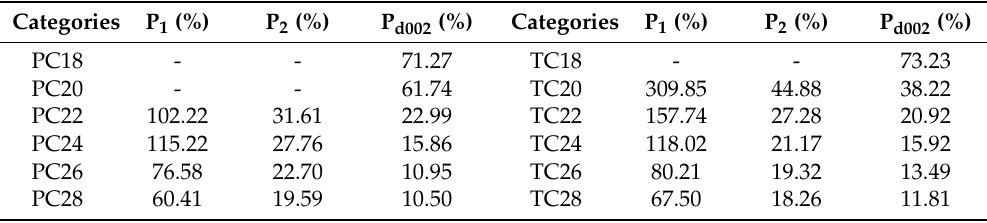
Table 3. The degree of stacking disorder of two kinds of coke anode